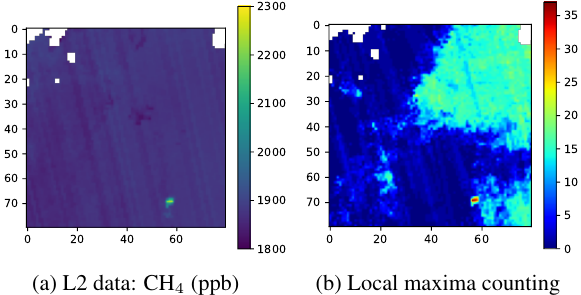
Figure 1. Figure (a) shows the concentration of methane in parts per billion (ppb) given by the L2 methane product from Sentinel-5P. A methane plume is visible in green. Pixels in white are discarded pixels (cloudy for example). Figure (b) gives the number of CH 4 spectrum maxima counted for each pixel in the original image with the proposed